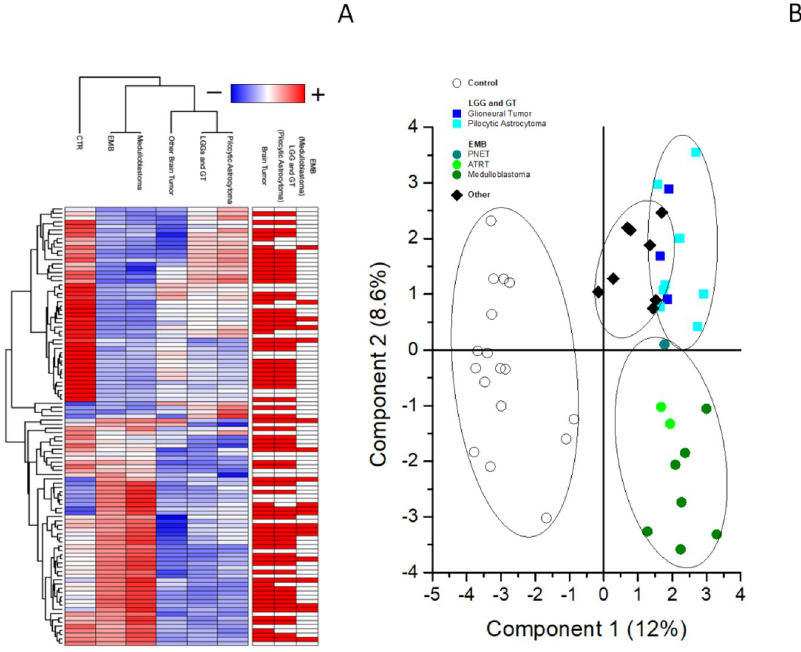
Figure 4. Heatmap and PLS-DA of highlighted proteins. ( A ) Heatmap of the proteome profile of 104 proteins highlighted by the statistical analysis (see Supplementary Table S3 for details). Each row represents a protein and each column a clinical group. Normalized Z scores of protein abundance are depicted using a pseudocolor scale (red, white and blue indicating positive equal and negative expression, respectively) compared to each protein value. The dendrogram displays unsupervised hierarchical clustering analysis. Similar sample/proteome- profile values are next to each other. ( B ) Scatter plot of PLS-DAS analysis of proteome profile of control (white circles), LGG and GT (blue and cyan squares), EMB (light and dark green circles) and other mixed brain tumors (black diamonds). Symbols and ellipsis indicate each sample and the 95% confidence interval of the four clusters. These proteins can clearly discriminate between the different conditions.